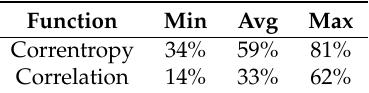
Table 5. Comparison of synchronization scores among correntropy and correlation functions; O . R . = 4, ± ∆ R = 4, and N . C . =